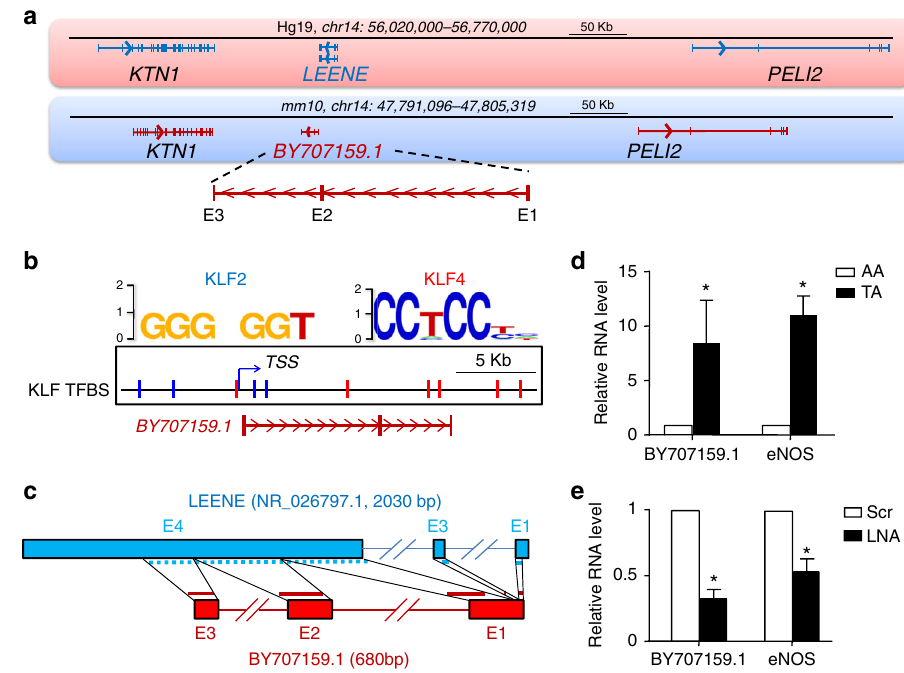
Fig. 7 LEENE homolog in mouse. a Comparison of human LEENE and mouse BY707159.1 loci. b Putative KLF2/4 TFBS in DNA region encoding BY707159.1 , indicated by blue (for KLF2) and red (for KLF4). c Sequence alignment between human LEENE and BY707159.1 . d Measurement of BY707159.1 RNA levels in thoracic aorta (TA) and aortic arch (AA) using qPCR. e qPCR of BY707159.1 and eNOS RNA level in isolated mouse lung ECs transfected with scramble or LEENE LNA. In each experiment, lungs from four animals were pooled for isolation and transfection. Data are average from four independent experiments. Error bars present mean ± SEM. * p < 0.05 between AA and TA in d and between scramble and LNA in e based on Student ’ s t